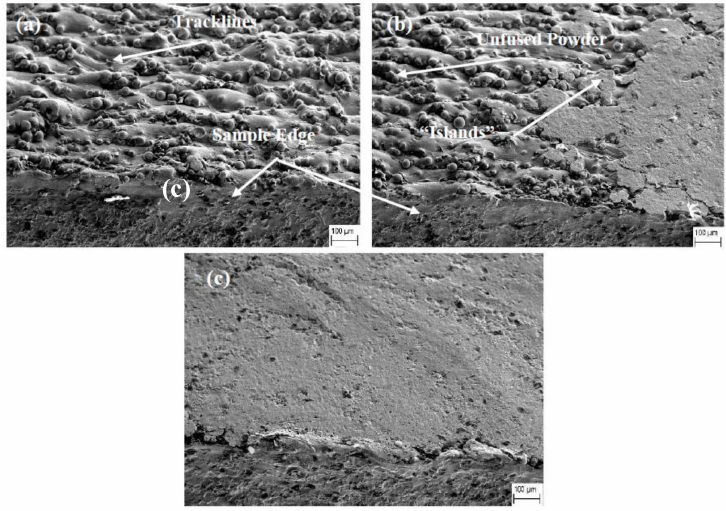
Figure 9. Specimens surface microscopy. ( a ) Surface of untreated specimen; ( b ) boundary zone between treated and untreated zone; ( c ) treated surface of specimen. All images taken with SE2 detector at 15